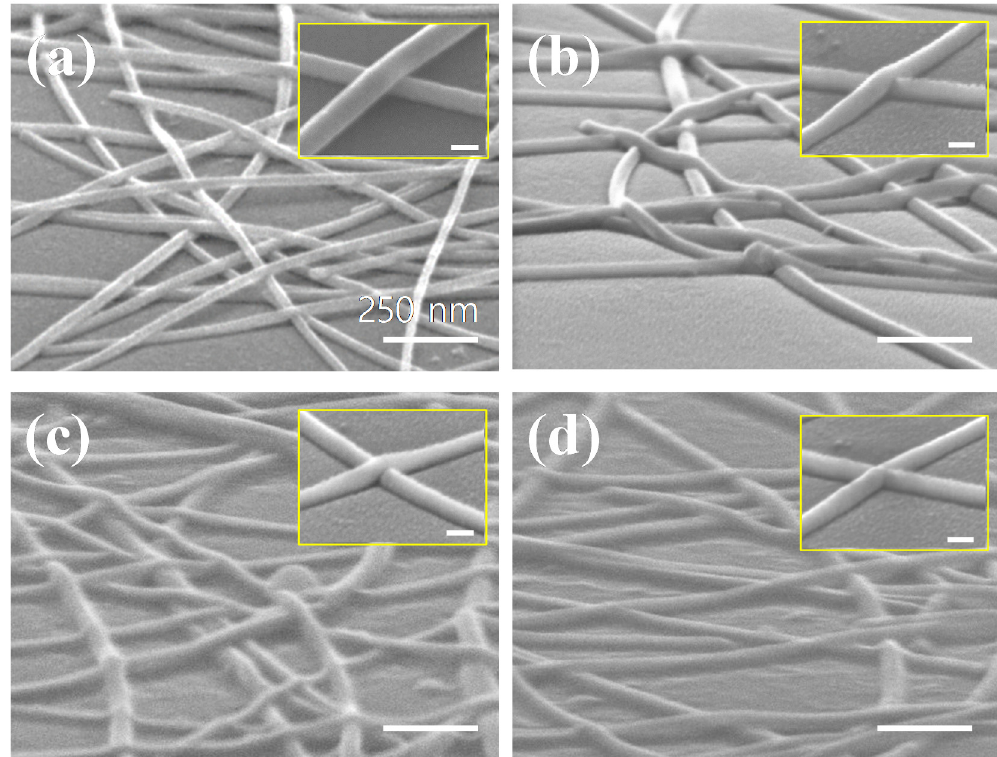
Figure 4. SEM image of the 100 ohm/sq Ag NW networks after inductive welding. ( a ) After the coating on the PEN substrate without welding; ( b ) after welding at 100 kHz; ( c ) after welding at 450 kHz; and ( d ) after welding at 800 kHz at 6 kW for 60 s. All of inset images are the morphology of nanowire junctions (scale bar: 30 nm).